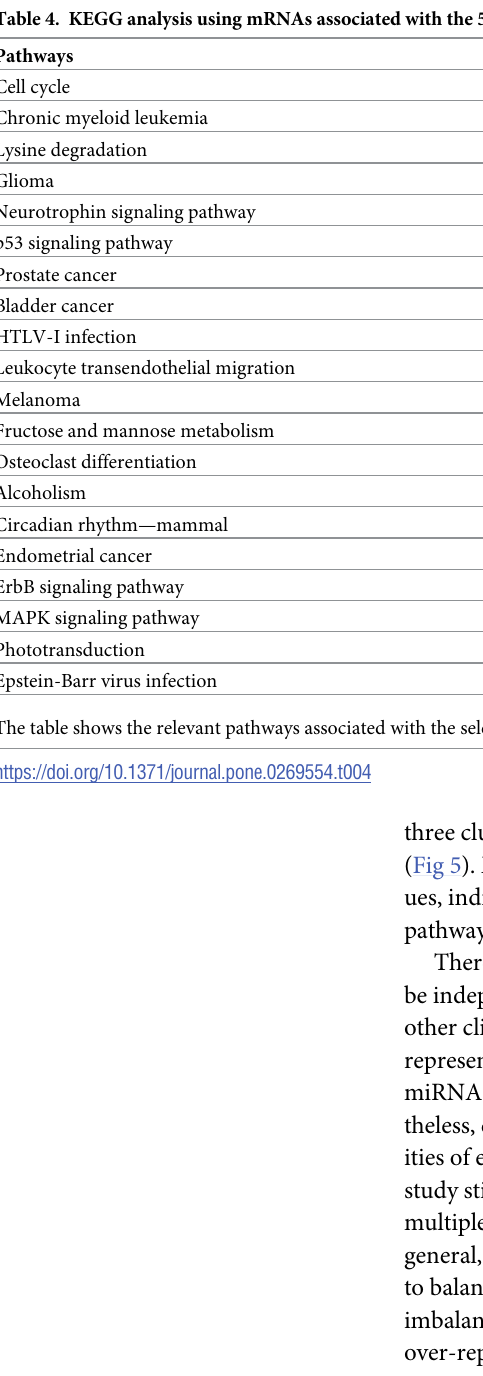
Table 4. KEGG analysis using mRNAs associated with the 5 selected miRNAs. Pathways